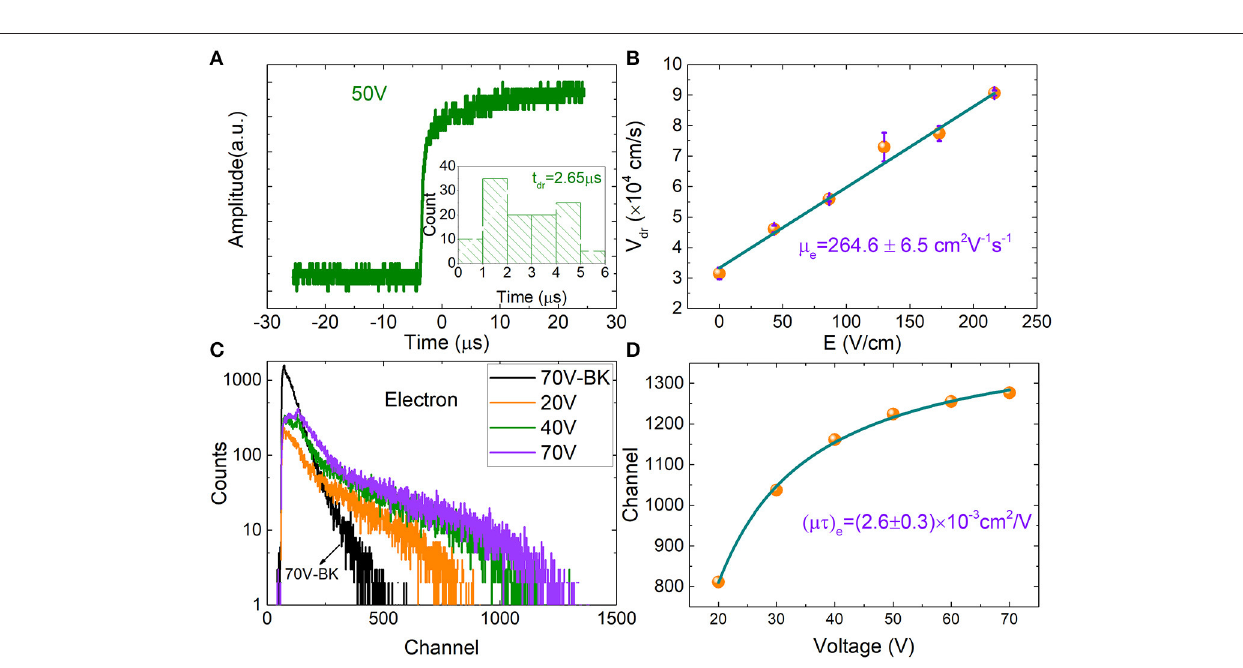
often happens on current–time curve measurements of 3D Pb- based perovskites samples. Maybe, Br ion migration leads to this